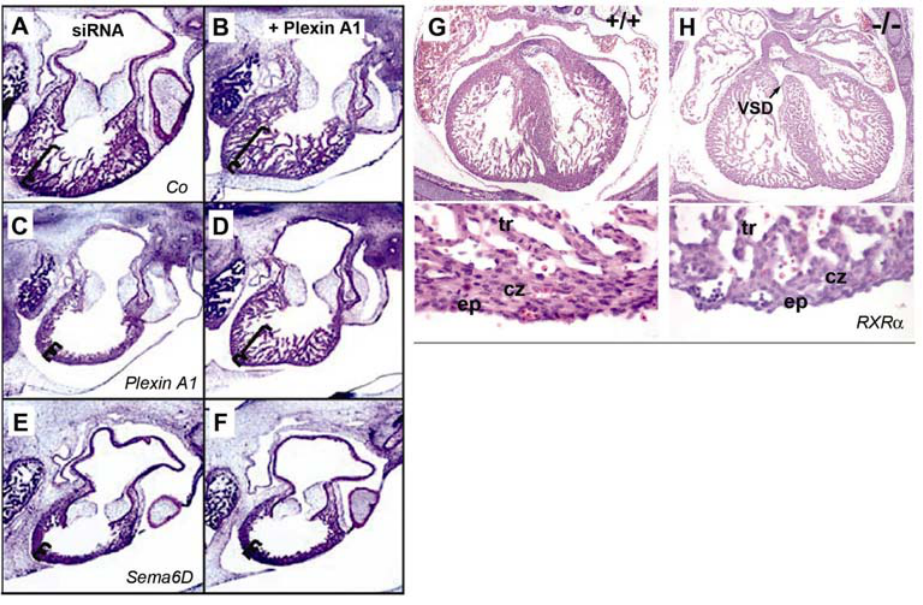
FIGURE 6. Development of the compact myocardium. (A–F) Cross-sections through HH-stage 10 chick embryos following electroporation of siRNA constructs in ovo . Plexin-A1- and Sema6D- specific siRNAs suppressed ventricular expansion and both trabeculations and compact myocardium formation (C,E). Injection of Plexin-A1 endocardial cells induces myocardial trabeculation in chick embryos treated with either control (B) or Plexin-A1 siRNAs (D), but not in embryos treated with Sema6D siRNA (F). Sema6D coordinates both compact layer expansion and trabeculation functioning as both a ligand and receptor for Plexin-A1; an example of forward and reverse signaling between compact and trabeculated myocardium to enhance migration of myocardial cells into the trabeculations. (G,H) Frontal sections through wildtype (F) and RXR α -/- (G) E14.5 embryos focusing on the heart. The RA signaling pathway is required for appropriate formation of the compact ventricular myocardium. Consequently, compaction is perturbed